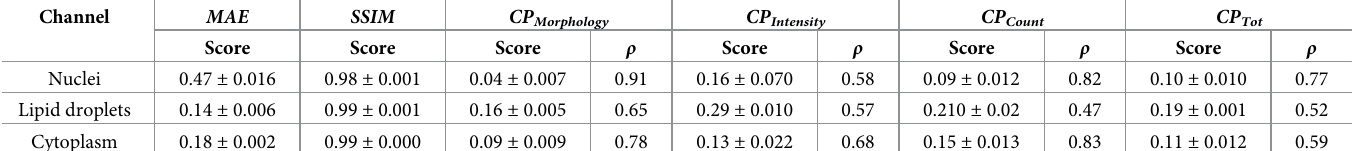
Table 3. Evaluation of the models for the three channels on the held out test set, where ρ denotes the Spearman correlation averaged across the results of the three models (from each training/validation split). Channel MAE Nuclei Lipid